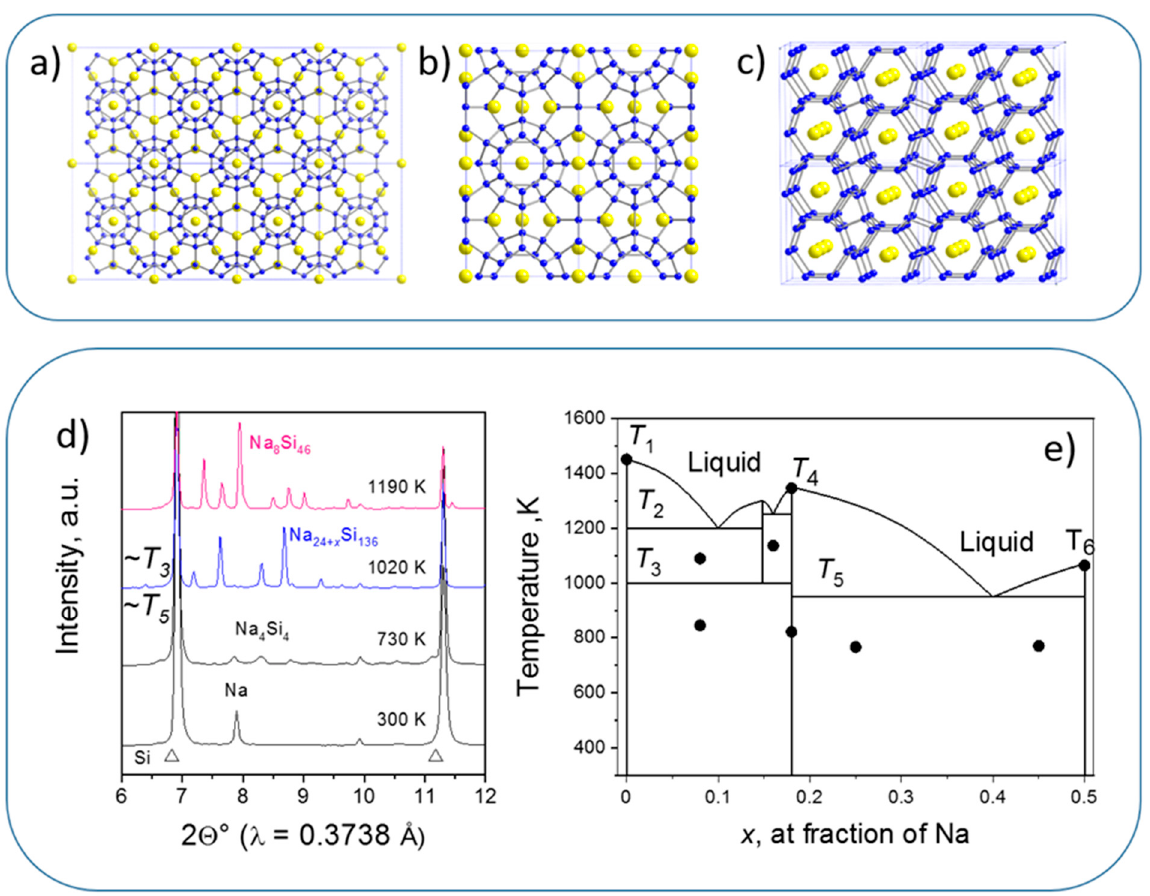
Figure 11. ( a – c ) Crystal structures of Na-Si stoichiometric clathrates: ( a ) Na 24 Si 136 —structure II or sII, ( b ) Na 8 Si 48 —structure I or sI, ( c ) Na 4 Si 24 or NaSi 6 . Blue balls indicate the atomic positions of Si atoms, while yellow balls—of Na. ( d ) In situ XRD data on phase/chemical transformations in the Na + Si mixture (~15 at % of Na) during heating at 4 GPa obtained at ID27 with Paris–Edinburgh press (ESRF) [97]. ( e ) First (experimental) approximation of phase diagram of the Na-Si system in the 5–8 GPa range that reflects in situ and ex situ observations [98]. Solid circles indicate experimental observations using either ex situ (phase compositions) or in situ (temperatures) techniques.